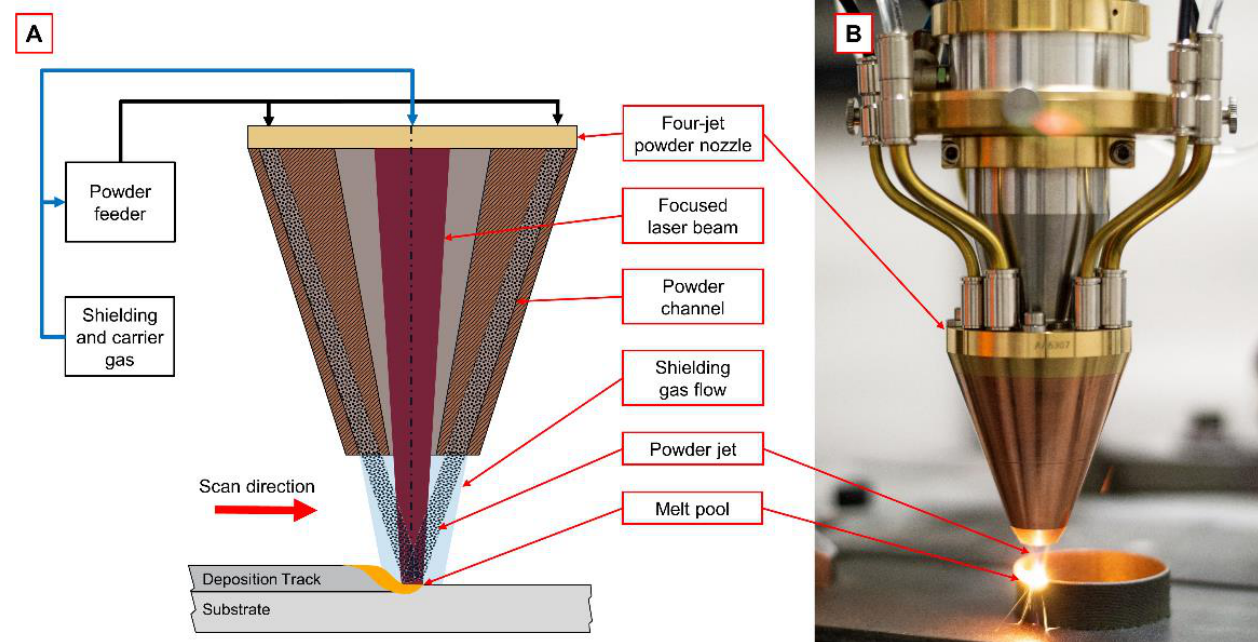
Figure 1. ( A ) Schematic diagram of DMD process using a four-jet powder nozzle. ( B ) DMD process during additive manufacturing of a cylindric demonstration part.